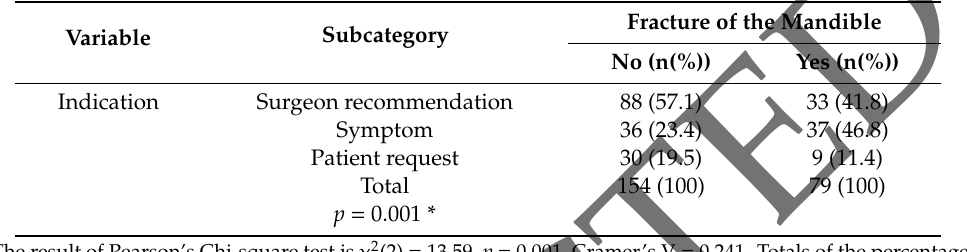
Table 6. Indication for plate removal in correlation with the date of plate